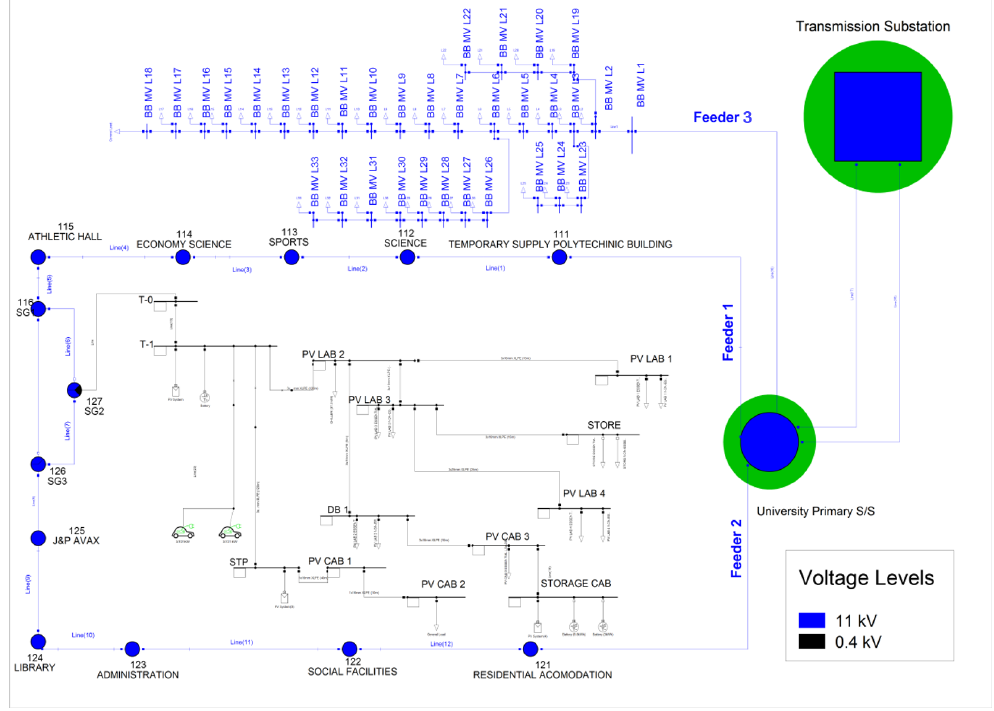
Figure 2. Modified IEEE 33-bus test system for evaluating the proposed